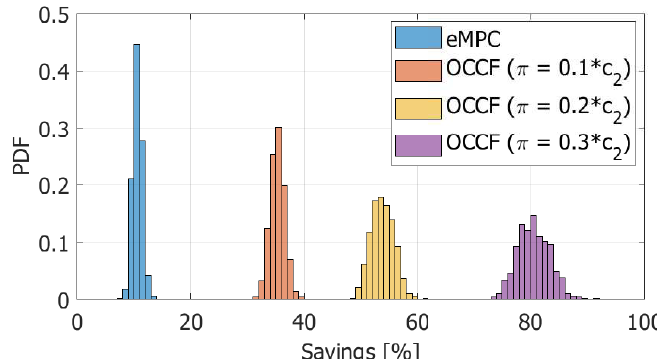
Figure 12. Overall savings for different strategies and remuneration factors based on c 2 .